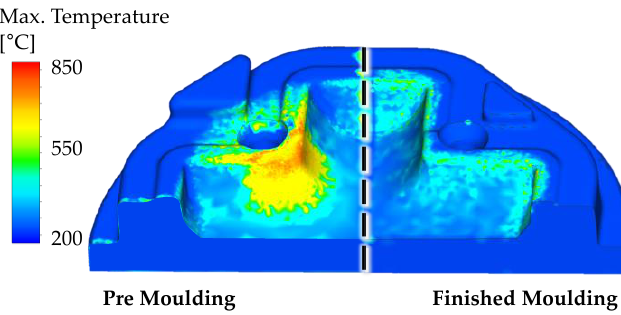
Figure 8. Maximum process temperature of the pre- and finished molding stage.